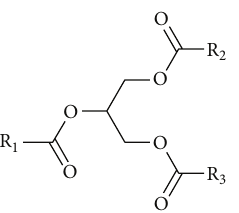
Figure 1: Schematic structure of vegetable oil (R 1 , R 2 , and R 3 -fatty acid).